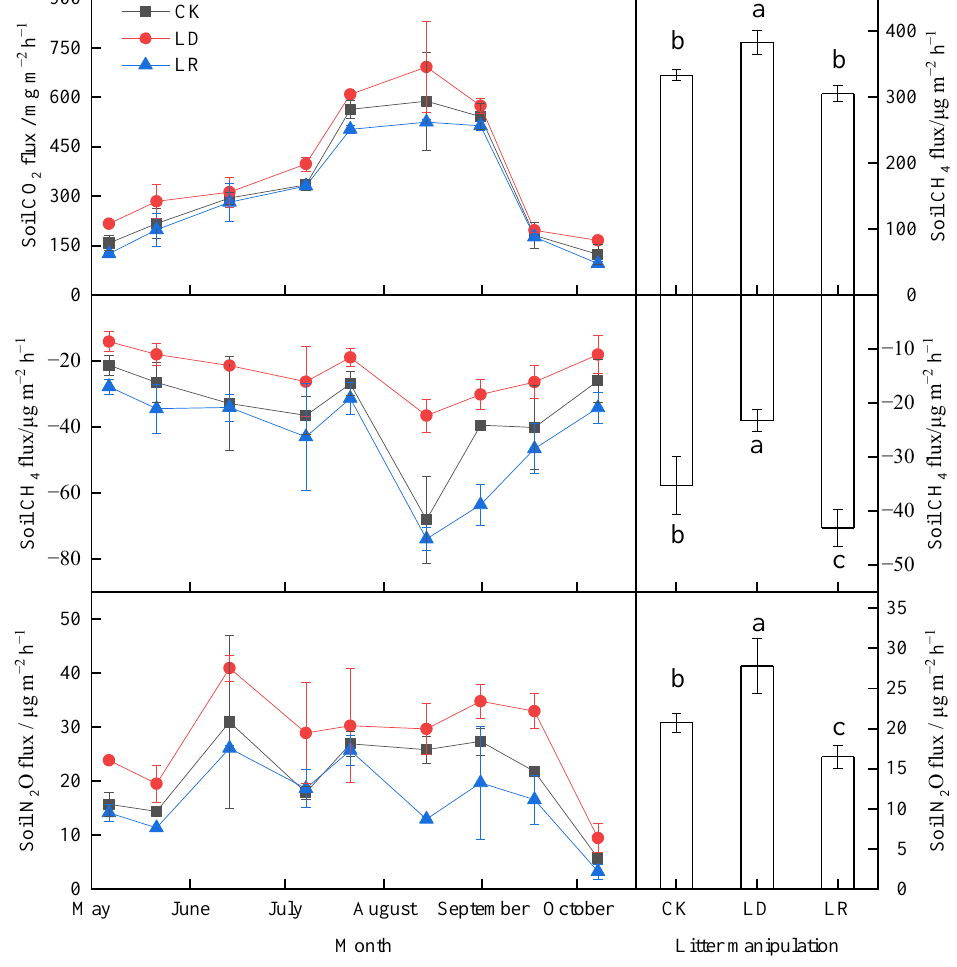
Figure 4. Temporal variations ( a , c , e ) and average ( b , d , f ) soil GHG emissions from the larch forest soils under different litter manipulation treatments during the study period ( n = 3). The different lowercase letters above the bars indicated significant differences among different litter manipulation treatments ( n = 27); values are the mean ± SD. Litter manipulation treatment abbreviations: CK, unchanged litter input; LD, doubled litter; LR, litter